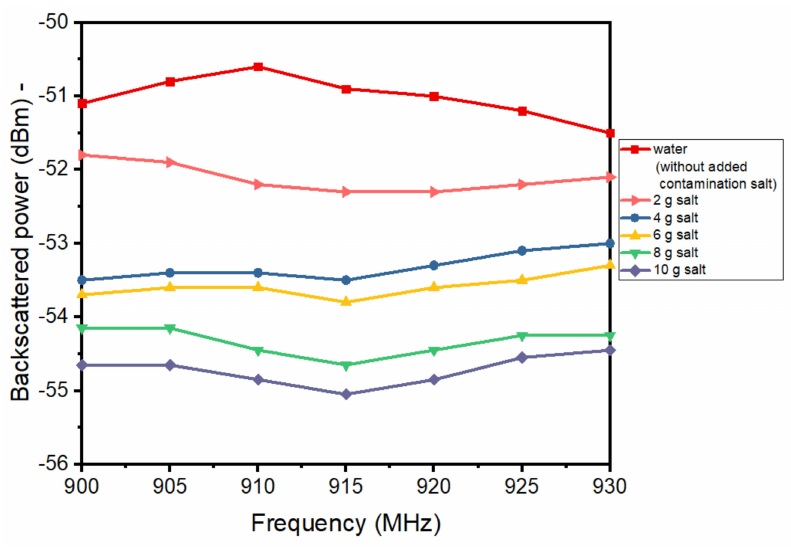
Figure 4. Measured RSSI using Tagformance setup with different quantities of salt as a